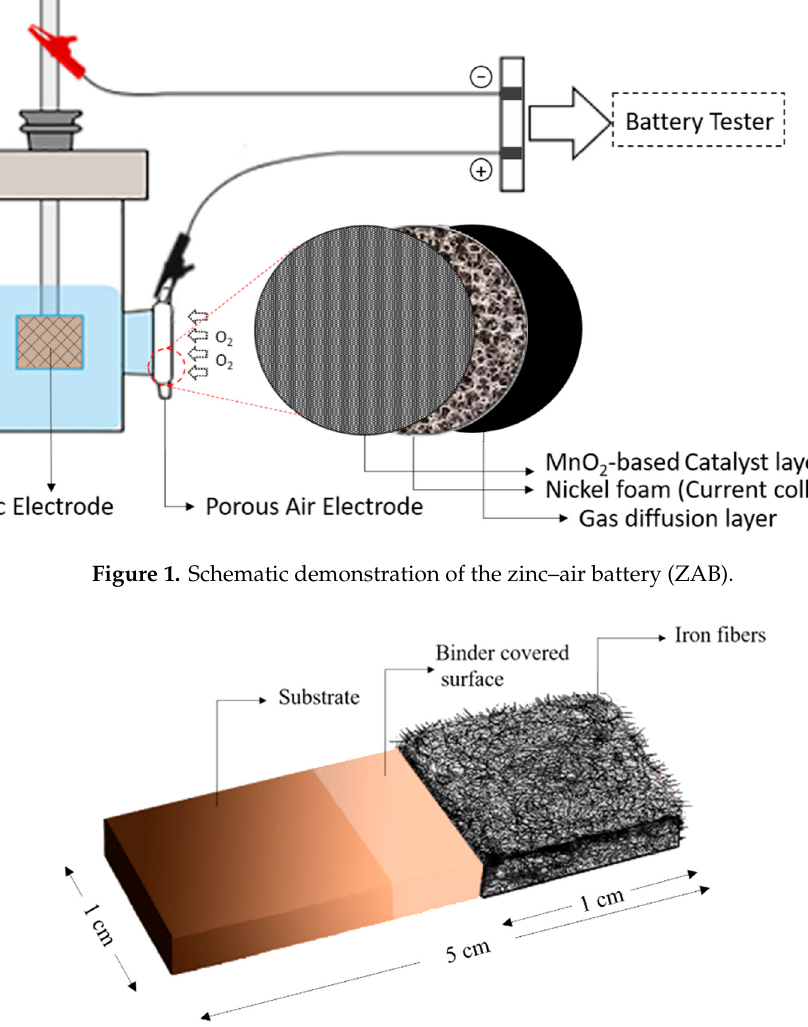
Figure 2. The anode electrode consisted of iron fibers (IF) adhered to the copper sheet.